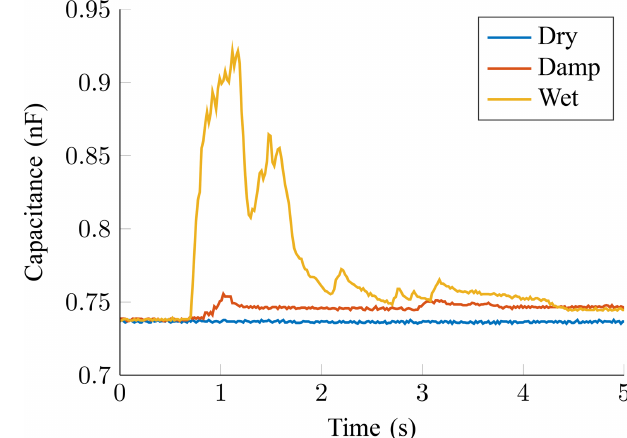
Figure 12. Field test results of capacitance against time for three different road surface conditions at 40kmh − 1 .